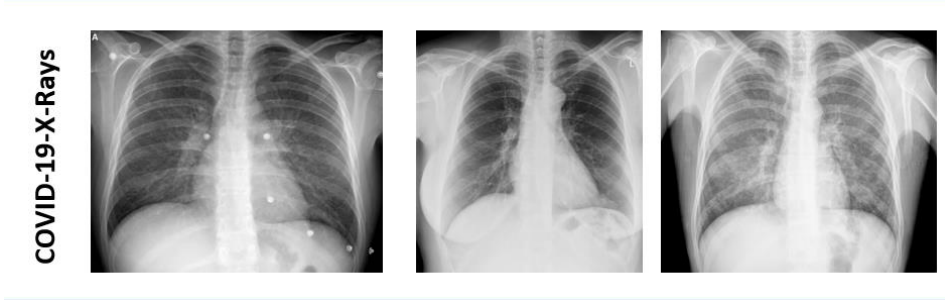
Figure 3. COVID-19 and normal X-Rays sample from the dataset.